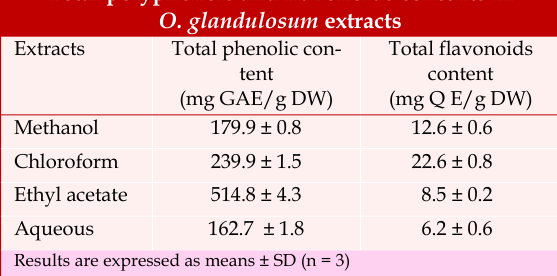
Total polyphenols and flavonoids contents in